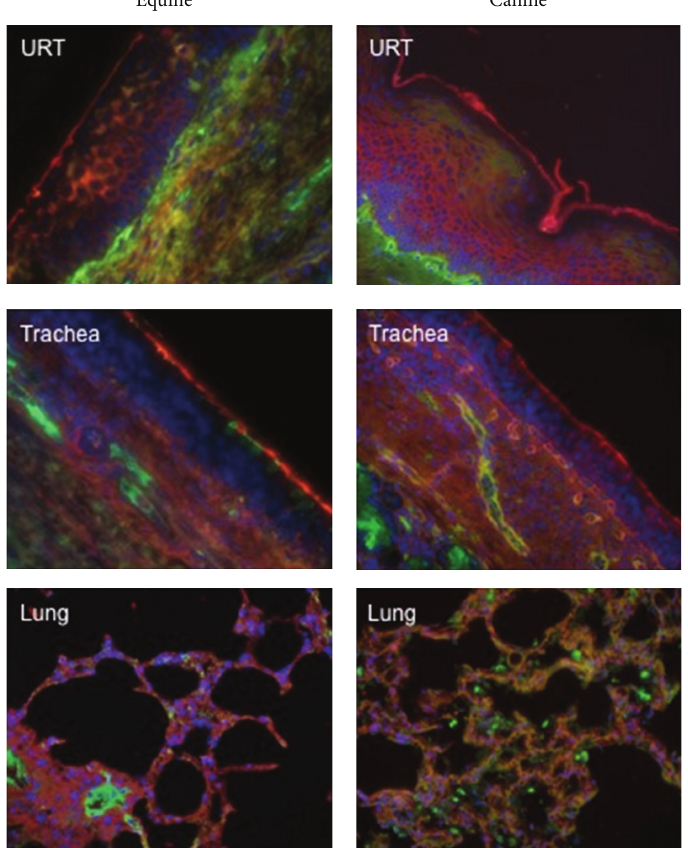
Figure 4: Equine and canine respiratory tissues for the upper respiratory tract (URT) and lower respiratory tract (trachea, lung) stained with lectins specific for sialic acids with 𝛼 2,6- and 𝛼 2,3-linkages. Green staining: reaction with fluorescein isothiocyanate (FITC)-labeled Sambucus nigra lectin (Vector Laboratories, Burlingame, CA, USA) indicates the presence of sialic acids linked to galactose by an alpha2,6- linkage (SA 𝛼 2,6-gal). Red staining: reaction with biotinylated Maackia amurensis lectin (Vector Laboratories) (detected with Alexa Fluor 594- streptavidin complex; Molecular Probes/Invitrogen, Carlsbad, CA, USA), indicates the presence of SA 𝛼 2,3-gal. Tissues were counterstained with 4,6,-diamidino-2-phenylindole (DAPI). Table 3: Statistical analyses of Ca/Wy and Eq/CO challenge groups compared to mock-inoculated negative controls. Temperature Clinical score Nasal shedding HIA antibody titer Ca/WY inoculated 𝑃 = 0.077 𝑃 =